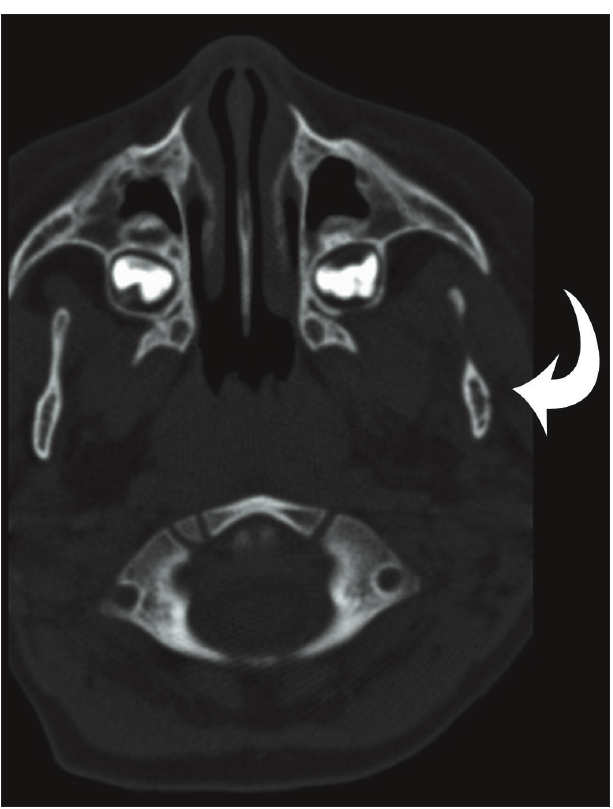
Fig. 1. Axial CT demonstrates a subtle left mandibular fracture